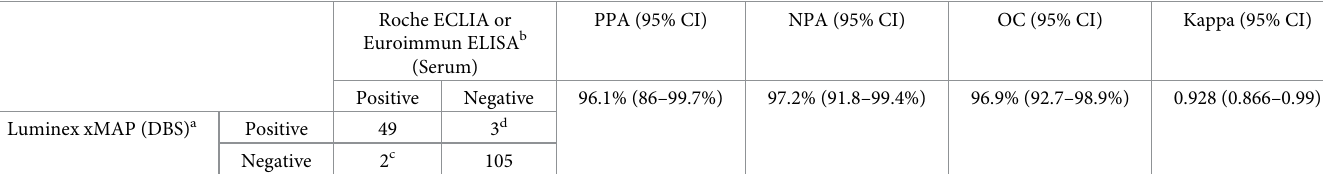
Table 1. Result comparison between 159 paired DBS and serum samples tested by the Luminex xMAP a and reference serologic assays for anti-SARS-CoV-2 antibodies.